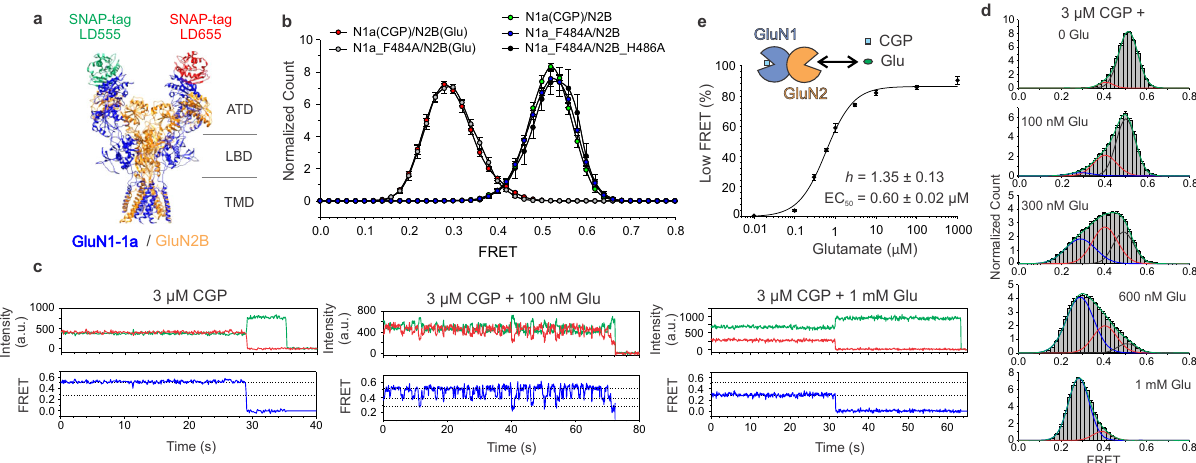
Fig. 1 Glutamate alone triggers two sequential steps of multidomain rearrangement. a Representation of SNAP_GluN1-1a/GluN2B fusion protein construct (C-termini are present but not shown; Protein Data Bank accession 3KZZ [https://doi.org/10.2210/pdb3KZZ/pdb] and 5IOU [https://doi.org/ 10.2210/pdb5IOU/pdb]). SNAP tags are randomly labeled by a mixture of donor (green) and acceptor (red) synthetic dyes. smFRET conformational readout of NMDAR ATD interdimer distance is obtained from receptors with one donor and one acceptor dye. b CGP is a neutral GluN1 ligand and mimics the Apo state of the receptor. GluN1-1a(F484A) and GluN2B(H486A) mutations decrease glycine and glutamate af fi nity by ~6000× and ~300×, respectively 56,71 . Each histogram n = 5 movies, SEM error bars. c Glutamate binding leads to increased ATD interdimer distance in two discrete steps. Representative donor (green) and acceptor (red) intensity traces and smFRET traces (blue) in the absence (top), intermediate 100 nM (middle), and saturating 1 mM (bottom) glutamate concentration. In all, 3 µ M CGP prevents binding by trace glycine. d smFRET histograms in the presence of various glutamate concentrations. Blue, red, and black lines show global 3-component Gaussian fi t of low, intermediate, and high FRET states, respectively. Green line shows the sum of all three components. Each concentration n = 5 movies, SEM error bars. e Glutamate dose – response curve in 3 µ M CGP (inset cartoon depicts CGP holding GluN1 LBD open and glutamate occupancy of GluN2B LBD depending on concentration; n = 5 movies, SEM error bars). Low FRET Gaussian fi t peak taken as a measure of the activated state. h Hill coef fi